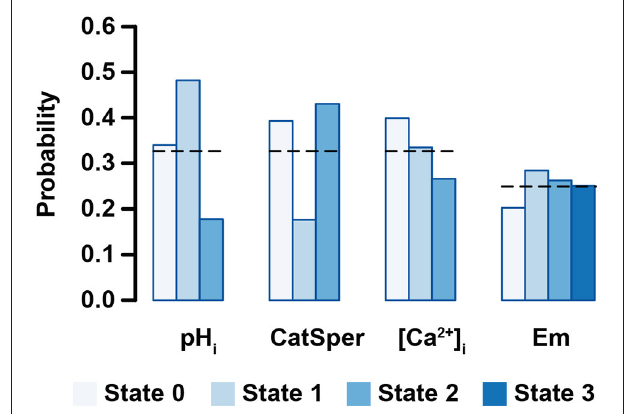
FIGURE 7 | Probability that one node takes a specific value in the set of initial states for non-binary nodes. Bar lengths show the average probability calculated over 2 × 10 7 initial states. Black dashed lines indicate the probability on a completely random set of initial states. Biological interpretation for each node is as follows: pH i (acidic 0, mildly alkaline 1, fully alkaline 2); CatSper (closed 0, open 1, inactivated 2); [Ca 2 + ] i (basal 0, activator 1, inhibitor 2); Em